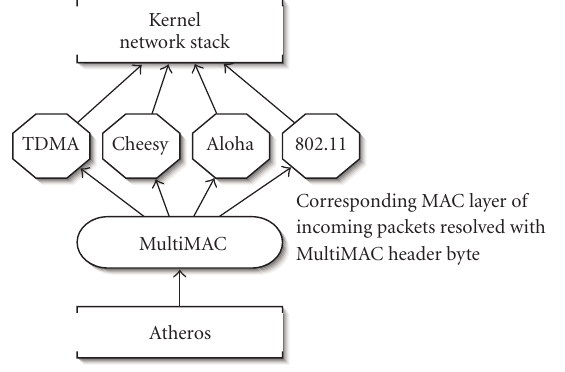
Figure 2: MultiMAC assigns received frames to the MAC layer that can decode them.